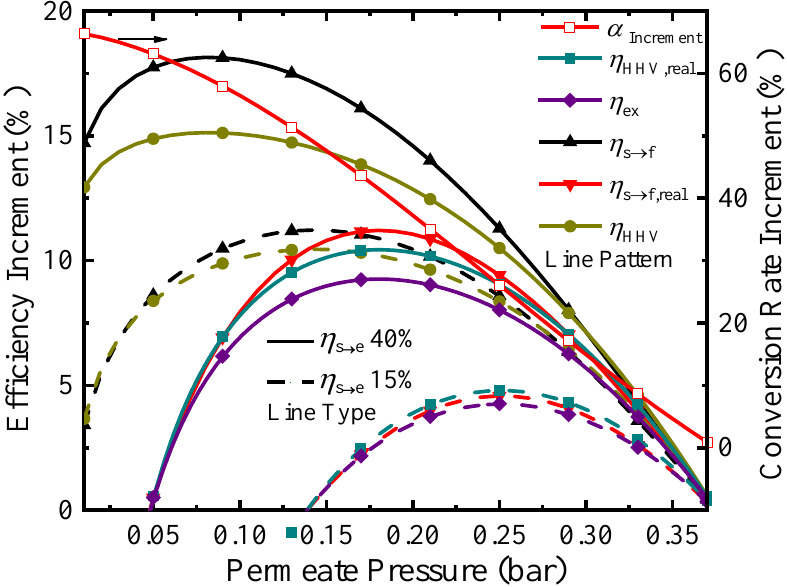
Figure 8. Increment of thermodynamic efficiency and conversion rate compared with those in a traditional reactor versus permeate pressure at a reaction temperature of 150 °C.